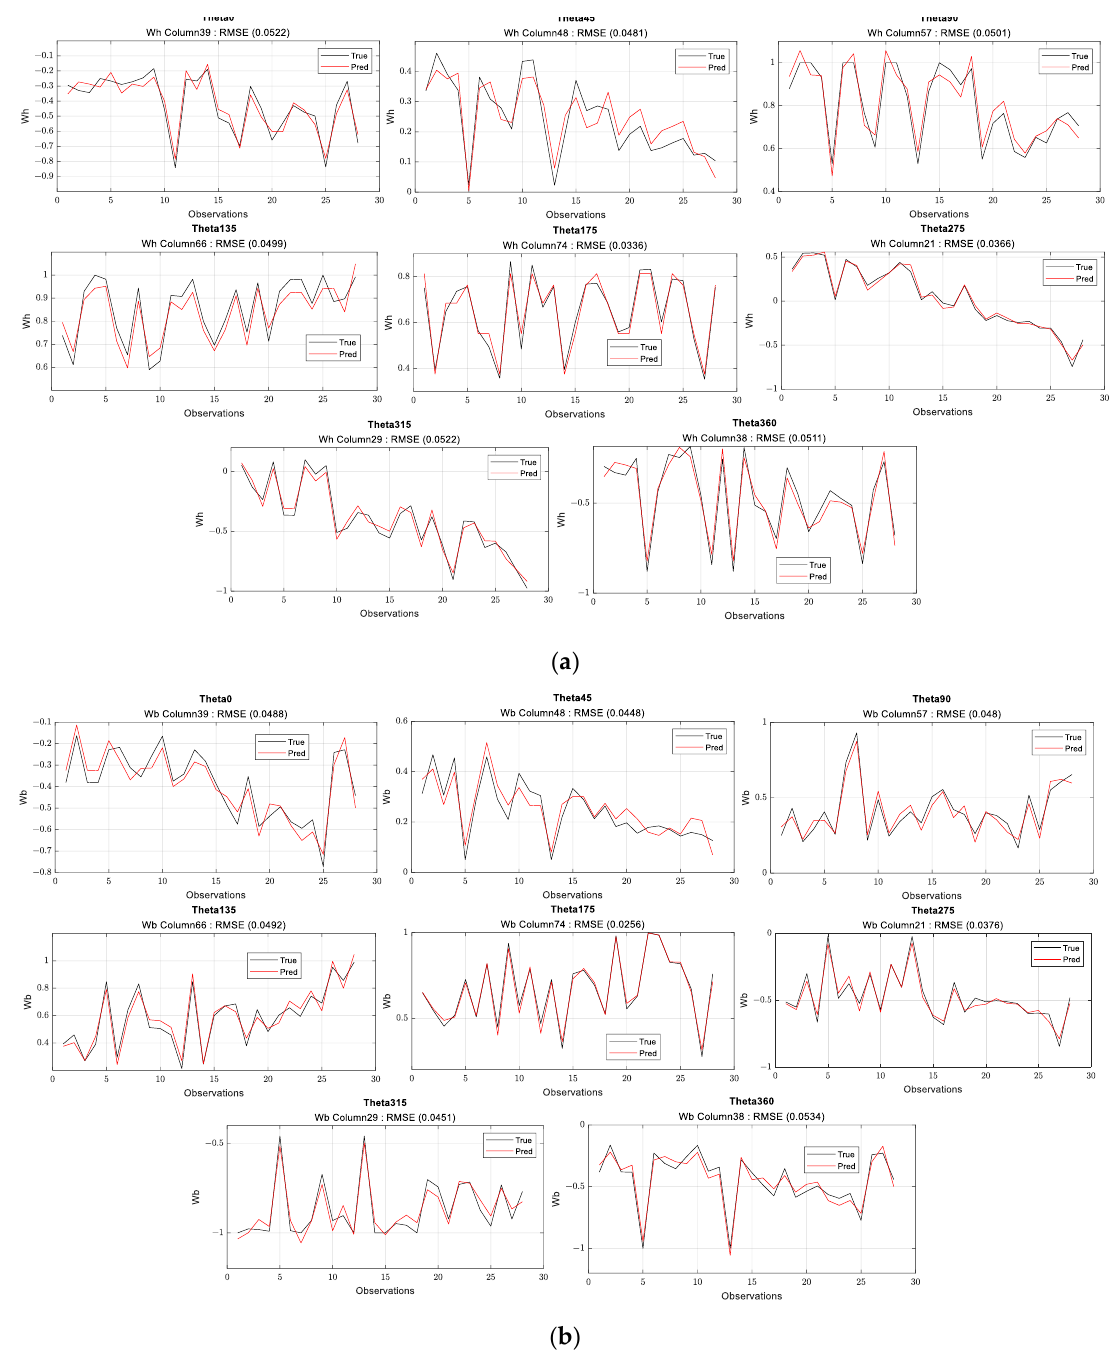
Figure 5. ( a ) Normalized dimensionless head test validation during training for all observations for column theta (0, 45, 90, 135, 175, 275, 315, 360). ( b ) Normalized dimensionless torque test validation during training for all observations under theta (0, 45, 90, 135, 175, 275, 315, 360). Pump-specific speeds are a key factor in describing a pump’s performance, but they are not the only factor since different types of pumps can have the same specific